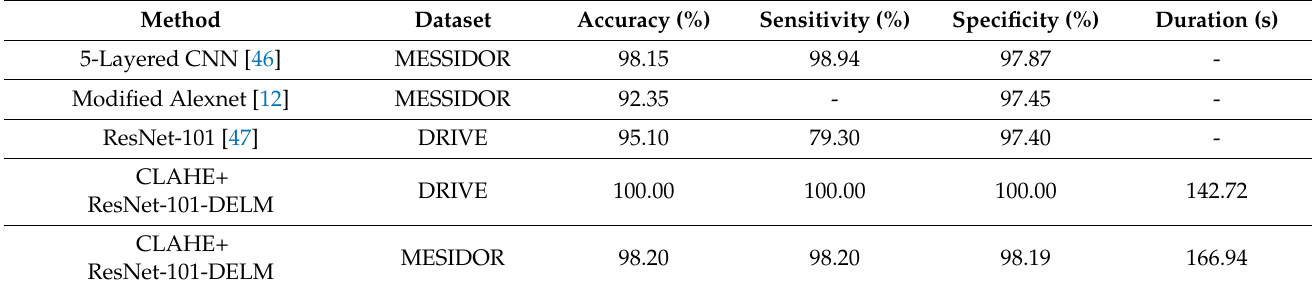
Table 8. Performance comparison of ResNet101 and